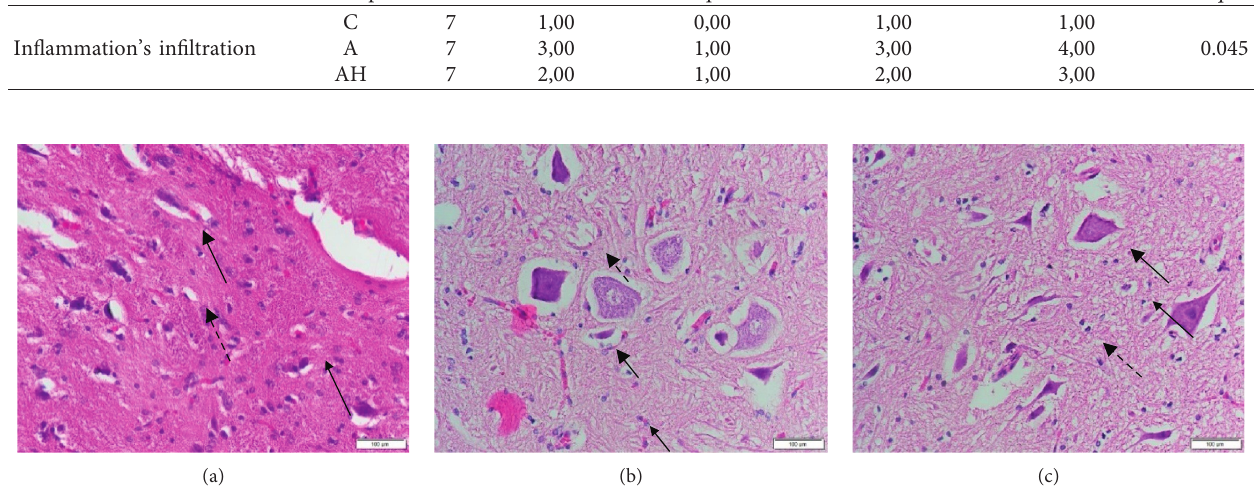
Figure 2: Hematoxylin and eosin-stained histopathological images at the cross section of the lumbar spinal cord. Microscopic views under 200 × magnification show normal white matter at the control group (a), moderate axonal degeneration at the AMAN group (b), and mild axonal degeneration at AMAN with the HBO group (c). (Bold line arrows indicate neuronal edema. Thin line arrows indicate macrophage infiltration. Dotted line arrows indicate lymphocytic infiltration.) The scale bars represent 100 μ